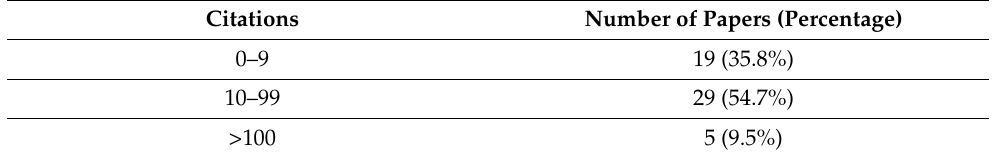
Table 7. Number of citations of non-survey works.